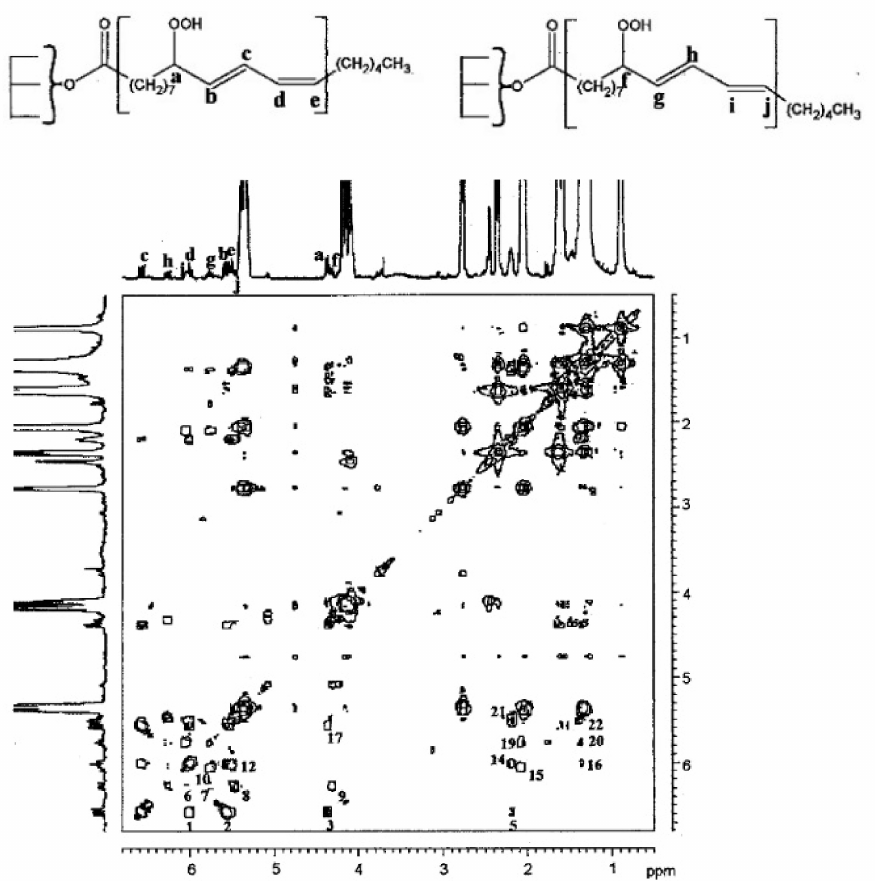
Figure 23. Selected 0.50–6.80 ppm region of a 400 MHz 1 H- 1 H relayed coherence transfer (RCT) spectrum of an oxidized sample of 1,3-dilinolein in CDCl 3 solution. Cross-peak assignments involving protons ( a – j ) of 9-hydroperoxy- trans -10, cis -12- (and in an analogous manner, 13-hydroperoxy- cis - 9, trans -11-) and 9-hydroperoxy- trans -10, trans -12-(and in an analogous manner, 13-hydroperoxy- trans - 9, trans -11-) octadecadienoylglycerol isomers are shown. Reprinted with permission from [111]. Copyright 1999,